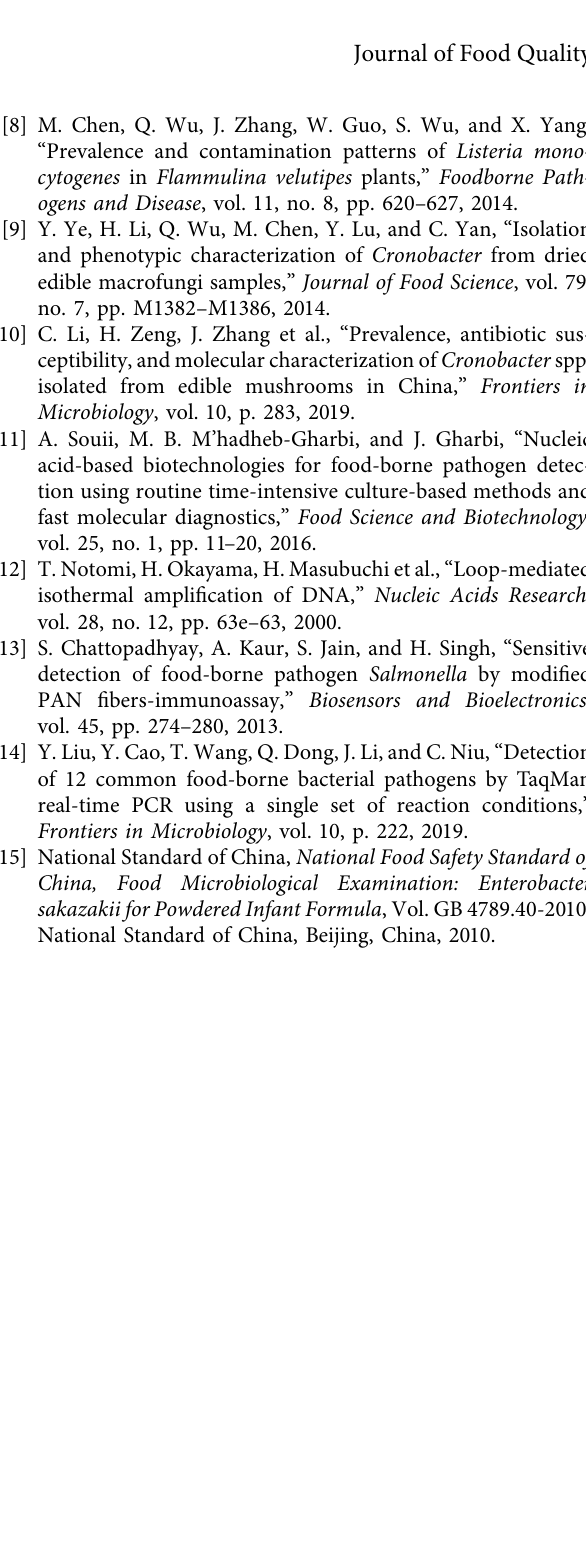
Table S1. PCR system for detection of characteristic 16S–23S sequence of C. sakazakii . Table S2. PCR reaction program for detection of characteristic 16S–23S sequence of C. sakazakii